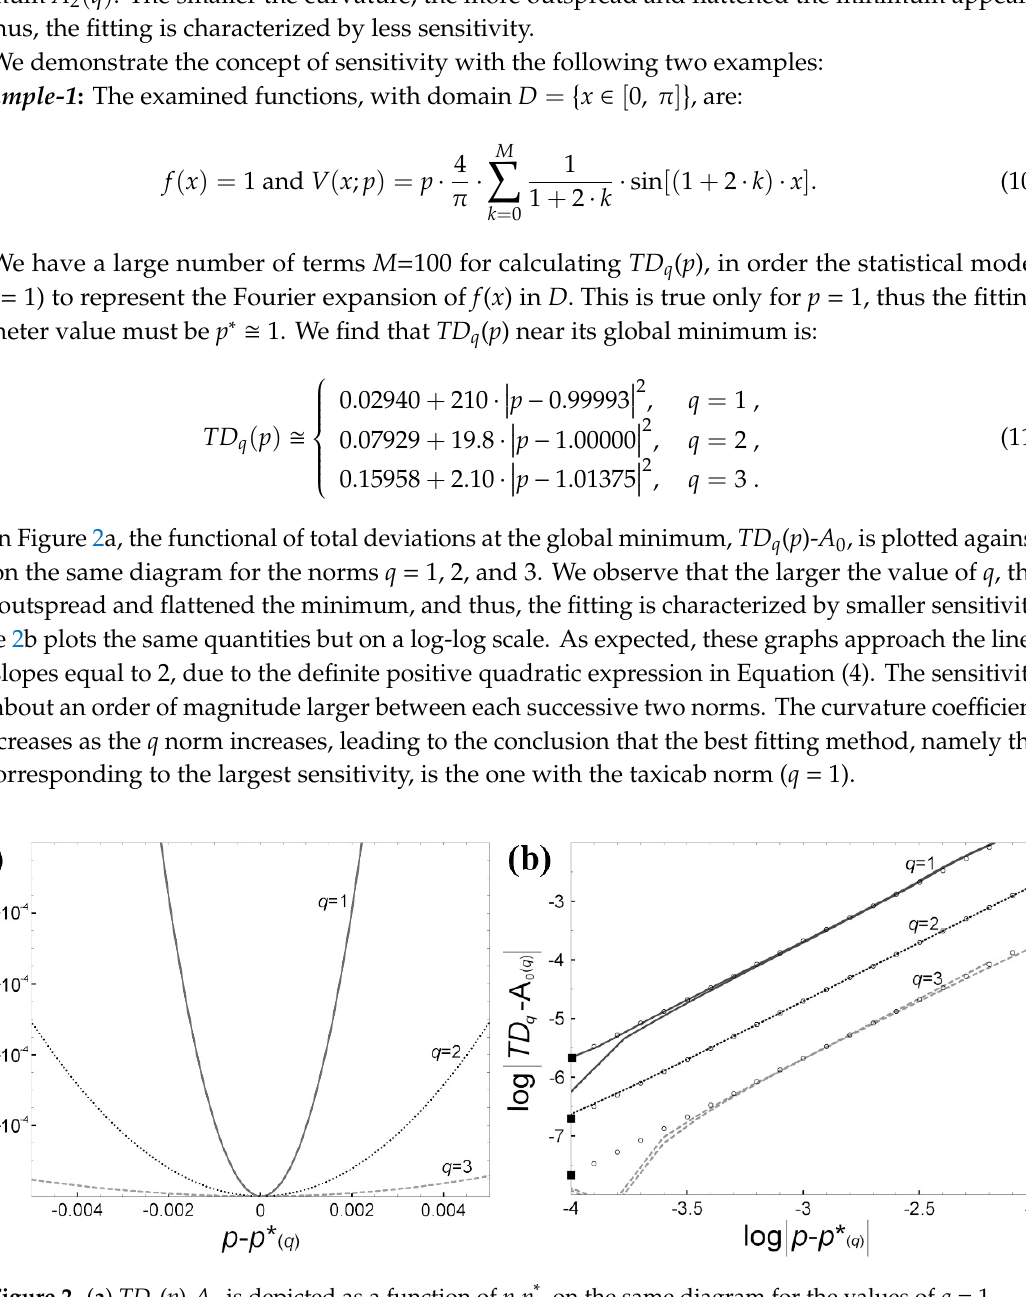
Figure 2. ( a ) TD q ( p )- A 0 is depicted as a function of p - p * , on the same diagram for the values of q = 1 (solid line), 2 (dot line) and 3 (dash line). ( b ) The same quantities are depicted on log-log scale. The slopes of the asymptotic lines (shown with circular points) are equal to 2. The curvature coefficient A 2 decreases as the q norm increases. Indeed, A 2 for q = 1 is about one order of magnitude larger than A 2 derived for q = 2, which is also about one order of magnitude larger than A 2 derived for q = 3 (Modified from reference [7]).